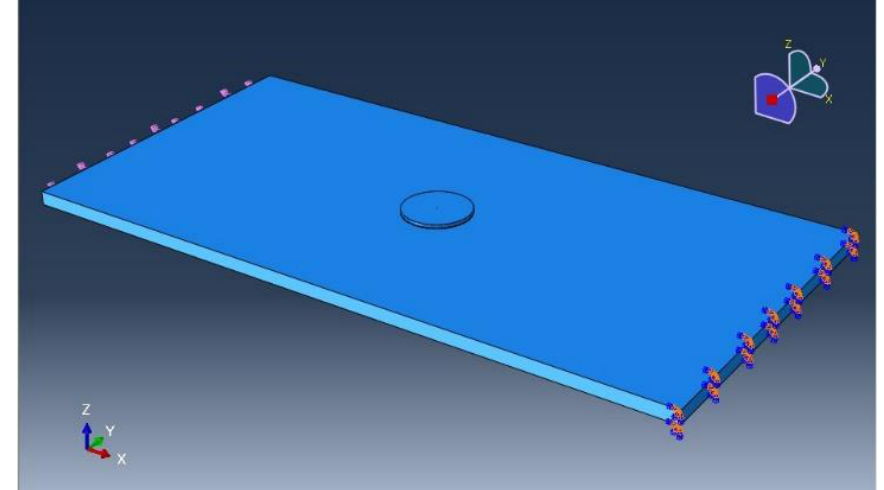
Figure 4. Sketch of the FEA model.